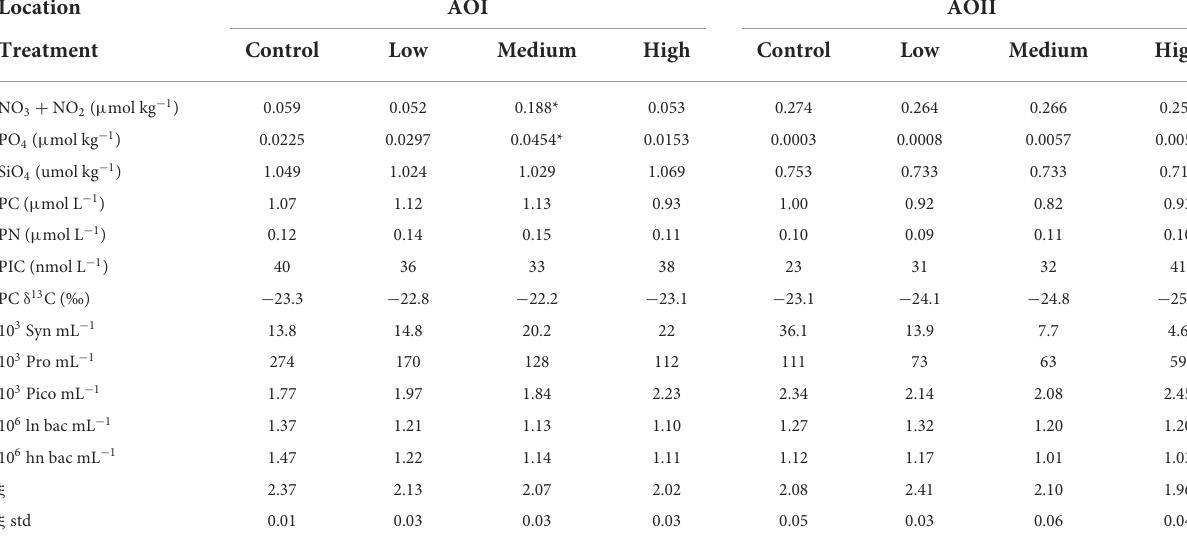
TABLE 2 t 0 information for all experiments at AOI and AOII.